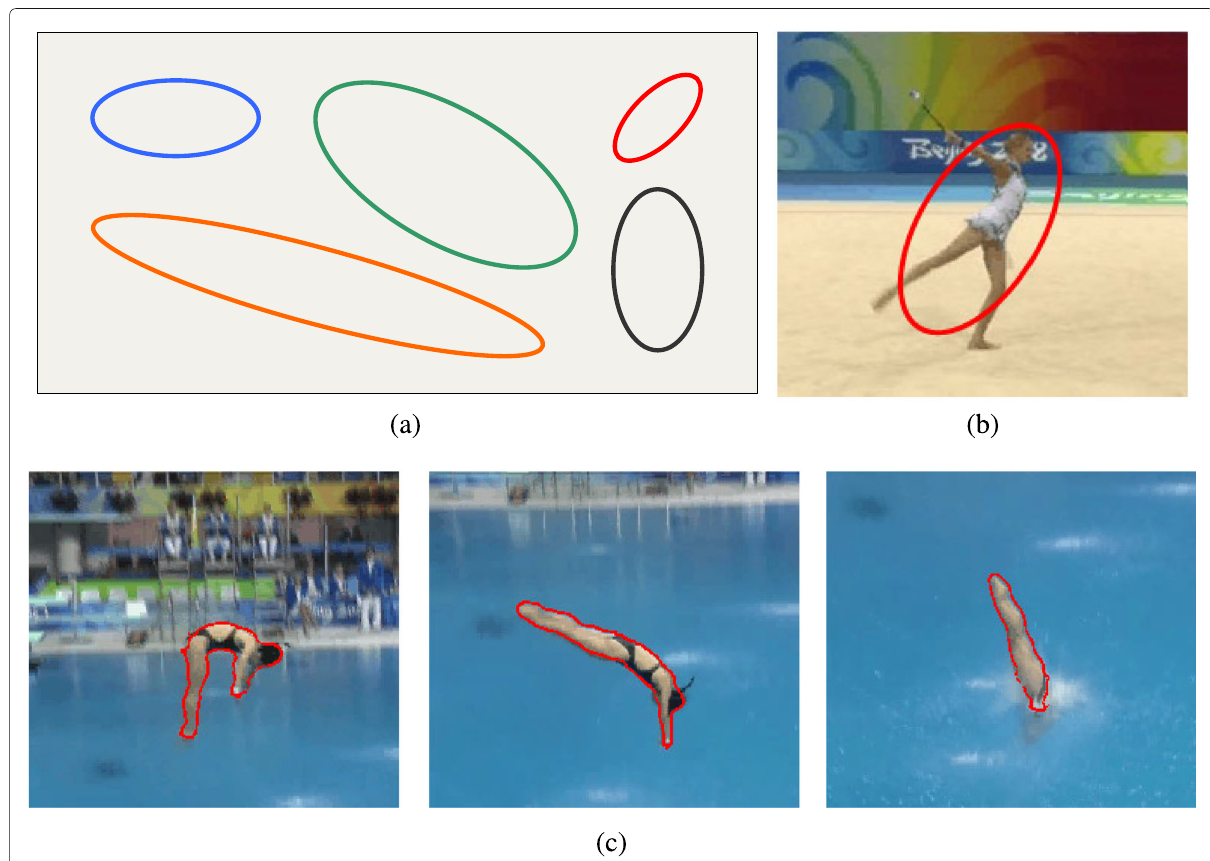
Fig. 1 Motivation and improvement illustration of the proposed method, the frame numbers of c are 191, 206, and 219, respectively, in diving sequence. a Kernel scale/orientation selection. b Complex object shape. c The proposed data-driven kernel and its adaptation to target variation